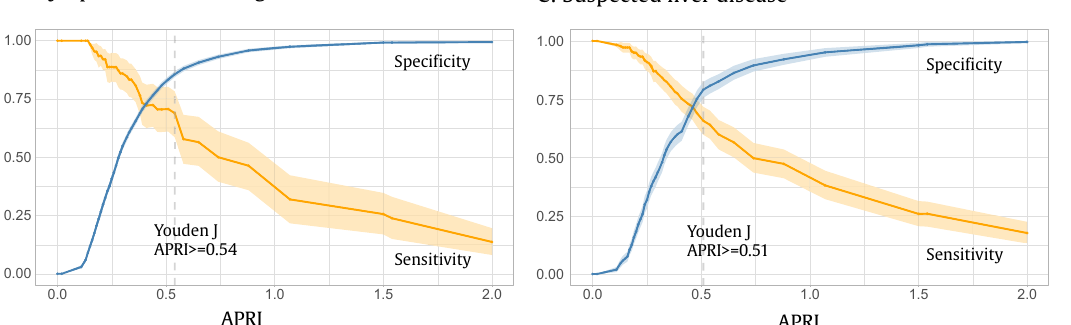
Fig. 4 | Relationship between sensitivity and speci fi city for APRI used to diagnose liver stiffness measurement >12.2kPa (associated with cirrhosis). Relationship among A all participants; B asymptomatic screening populations and C patients with suspected liver disease a . Point estimates at different APRI thresh- olds are shown as blue (speci fi city) or orange (sensitivity) dots, connected by straight line segments with 95% credible intervals shown as transparent error